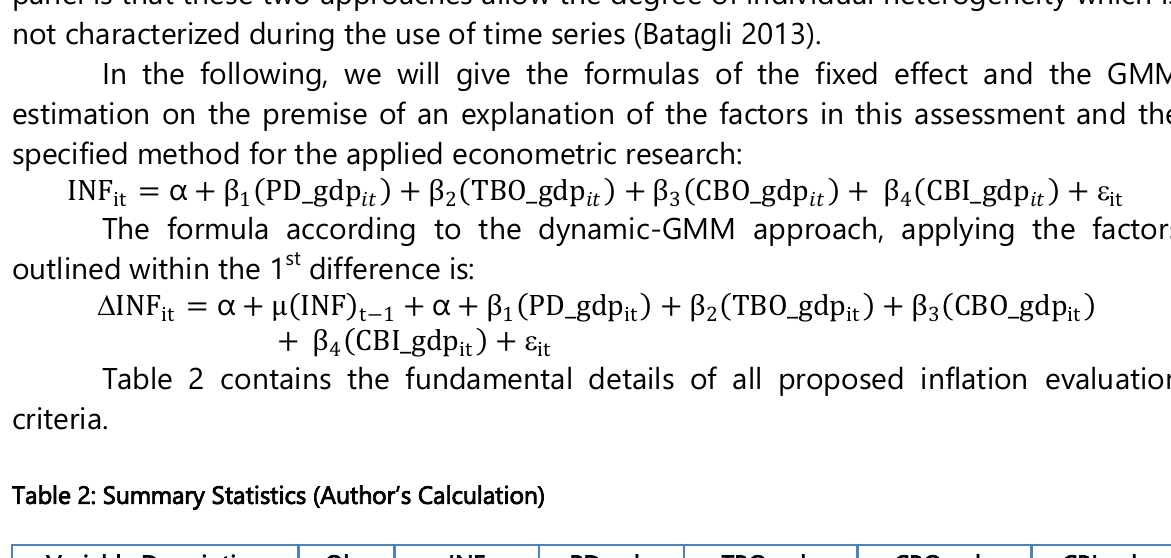
Table 2: Summary Statistics (Author’s Calculation) Variable Description Obs INF Smallest Largest Mean Standard deviation Skewness 90 Kurtosis